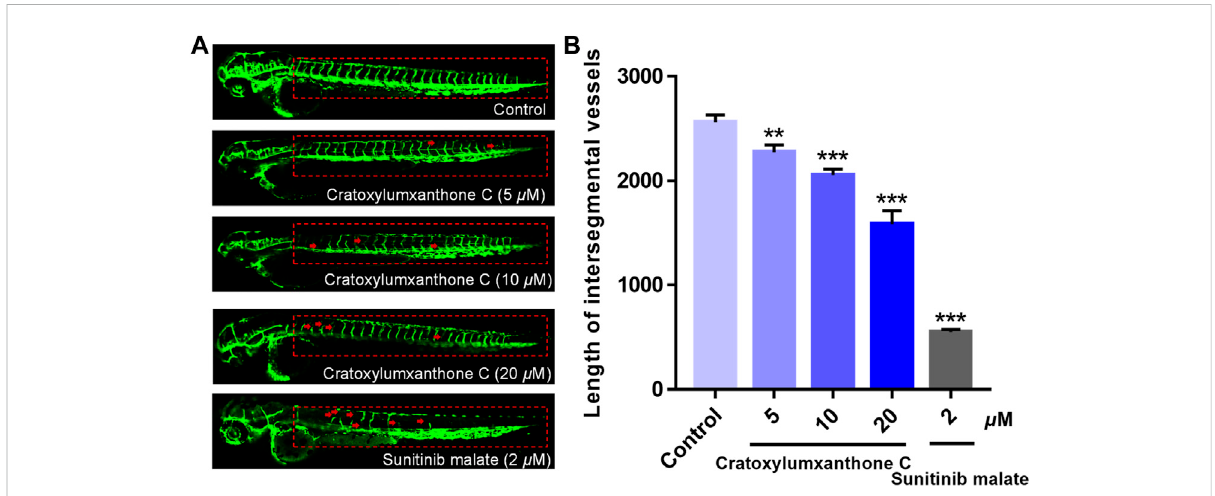
FIGURE 9 The embryos from transgenic zebra fi sh Tg( fl i1: EGFP) were treated with cratoxylumxanthone C (5, 10, and 20 μ M) and the positive control, sunitinib malate (2 μ M) for 48 h. (A) The development of intersegmental vessels (ISVs) was observed under a confocal microscope. (B) The average lengthofISVsofzebra fi shaftertreatingwithcratoxylumxanthoneC(5,10,and20 μ M)andsunitinibmalate( n =15/group).Allresultsareexpressedas the mean ± SD. ** p < 0.01 and *** p < 0.001 versus the control